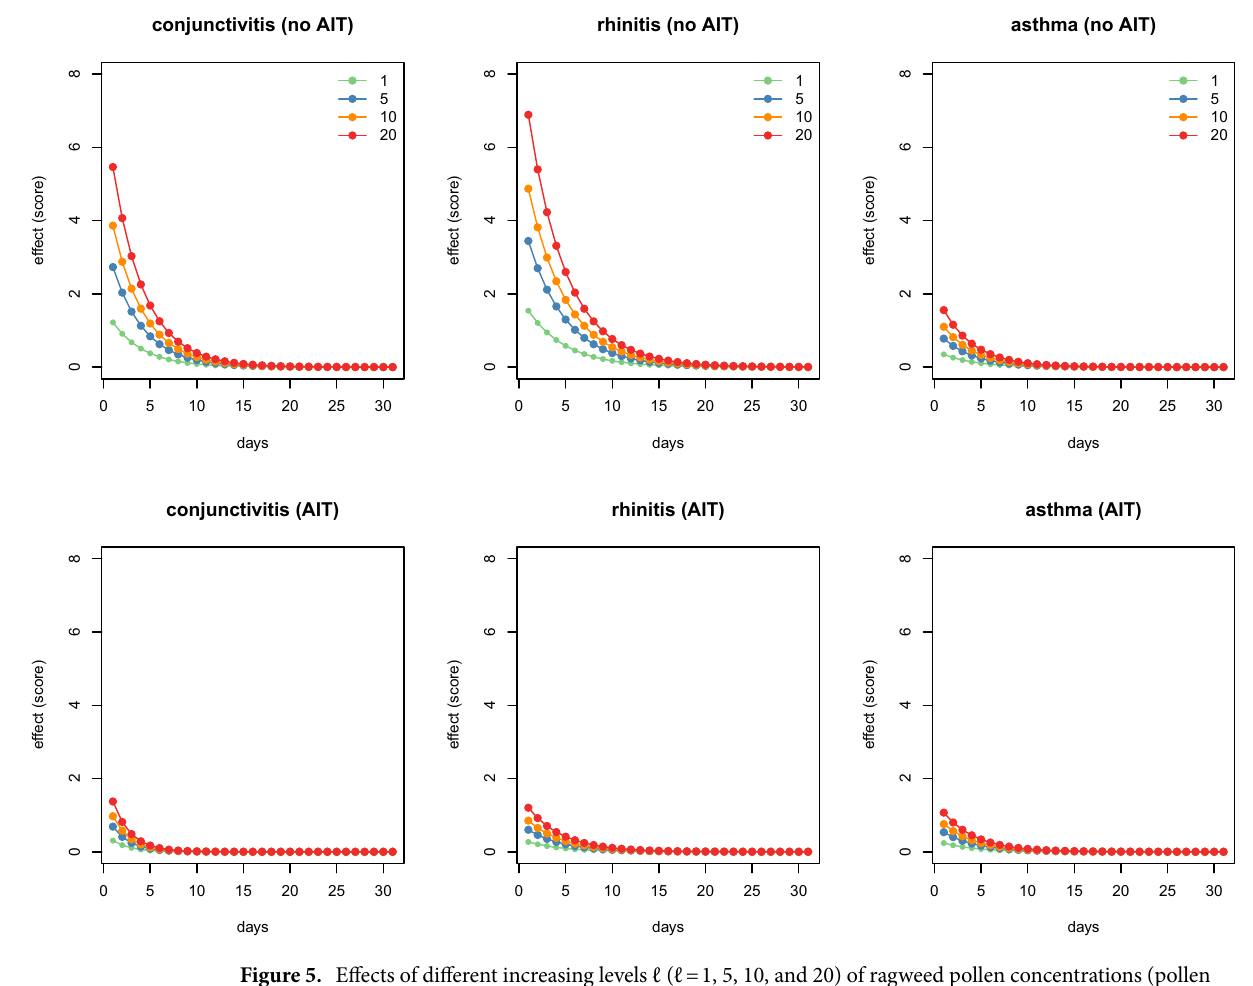
Figure 5. Effects of different increasing levels ℓ (ℓ = 1, 5, 10, and 20) of ragweed pollen concentrations (pollen grains/m 3 ) on the total symptoms score in AIT treated and no AIT patients for conjunctivitis, rhinitis, and asthma-like symptoms.